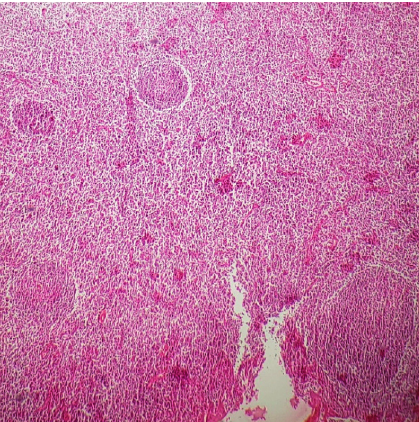
Figure 3: Lymphoid follicles within the tissue (H&E stain, × 100).